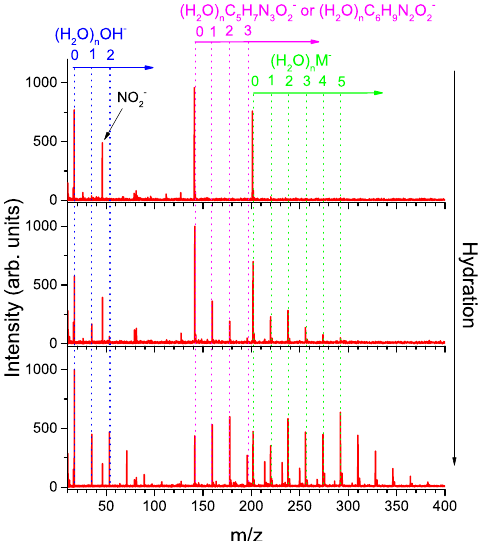
Figure 1. Cumulative mass spectra for negative ion formation after interaction of electrons in the 0.6–5.6 eV range with MISO in a molecular beam without hydration and at two different levels of hydration. The number of water molecules attached to misonidazole in the neutral precursor cluster increases from top to